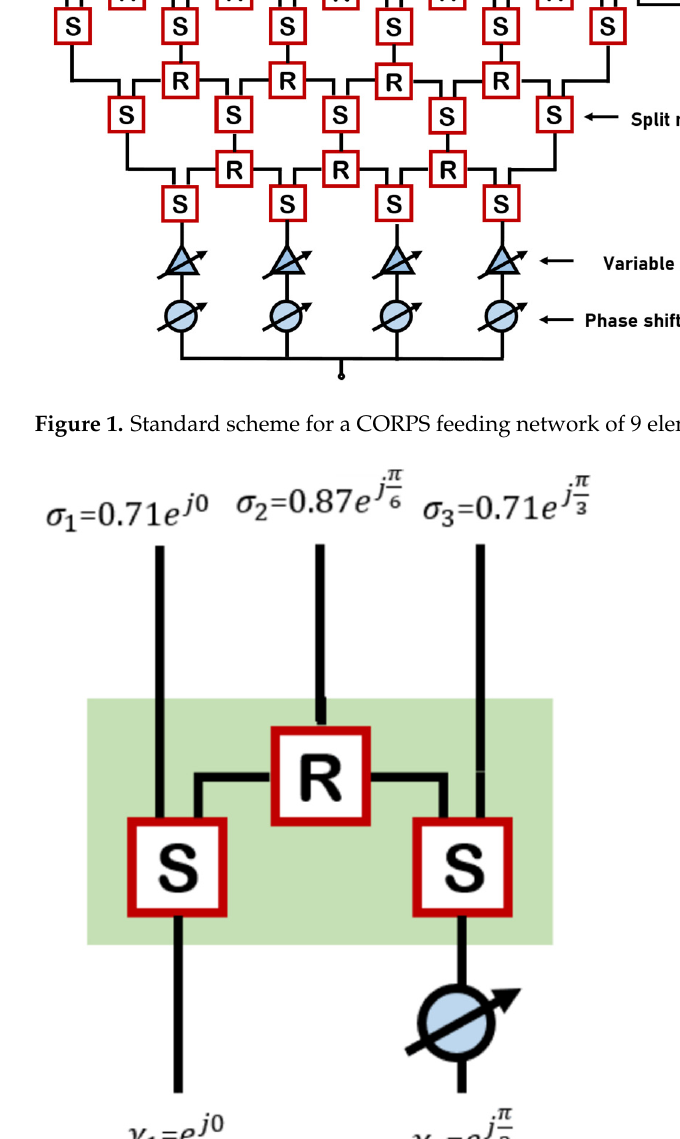
Figure 1. Standard scheme for a CORPS feeding network of 9 elements and 4 input ports.